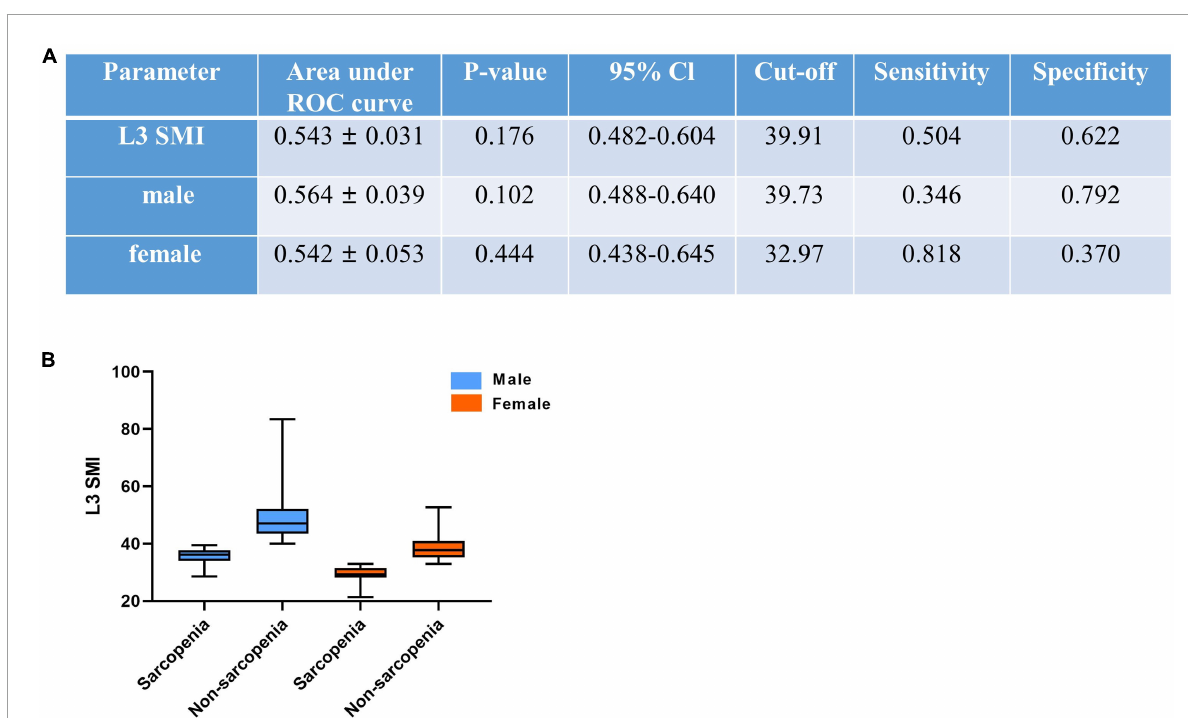
TNM (II and III) [hazard ratio (HR), 4.424; 95% CI, 1.723– 11.355; p = 0.002; HR, 12.231; 95% CI, 4.981–30.035; p = 0.000], depth of invasion [T3-4] (HR, 4.810; 95% CI, 2.894–7.994;